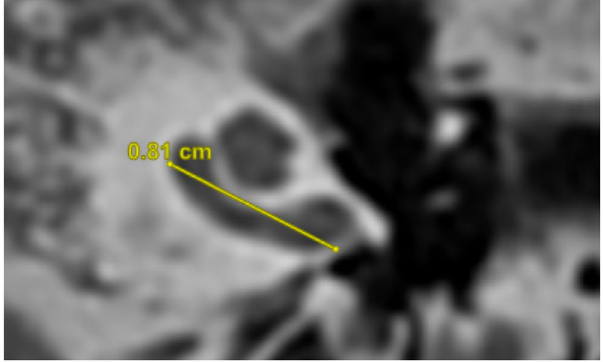
Figure 4. Example of a measurement of the A value on the traditional 2D oblique view in PACS viewer. Cochlear diameter, known as the A value is shown.